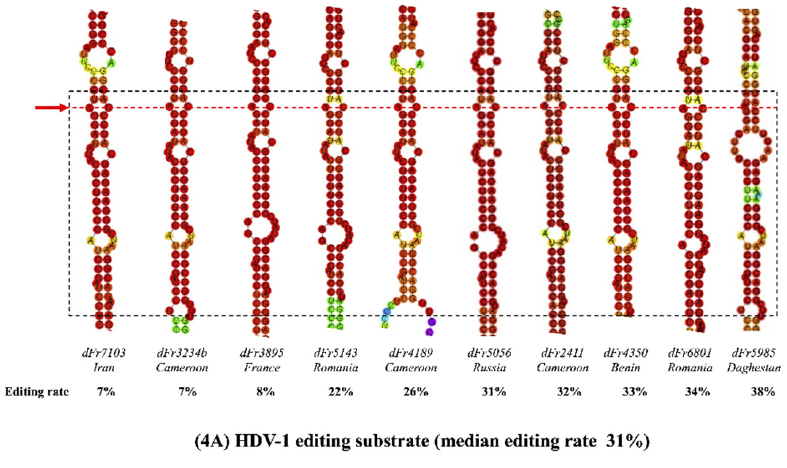
Figure 3. Schematic representation of ADAR-1 binding on the putative minimum editing substrate from the Italian HDV genotype 1 strain (accession number: X0445Italy1976). ( A ) The secondary structure of the complete sequence of antigenomic RNA is shown. The dashed black square delimitates the minimal editing substrate region for host enzyme ADAR-1. ( B ) ADAR-1 binding model on the putative minimum editing substrate. The unbranched rod-like structure with base-pairing domains of the HDV RNA minimal editing substrate is shown. ADAR-1 binding mediated by the 3 dsRNA-binding motifs (DRMBs) is drawn. The red arrow indicates the amber/W editing site with the target adenosine for editing, while the A-C mismatch is highlighted. The color scale indicates relative base-pairing probabilities from 0 (violet) to 1 (red).